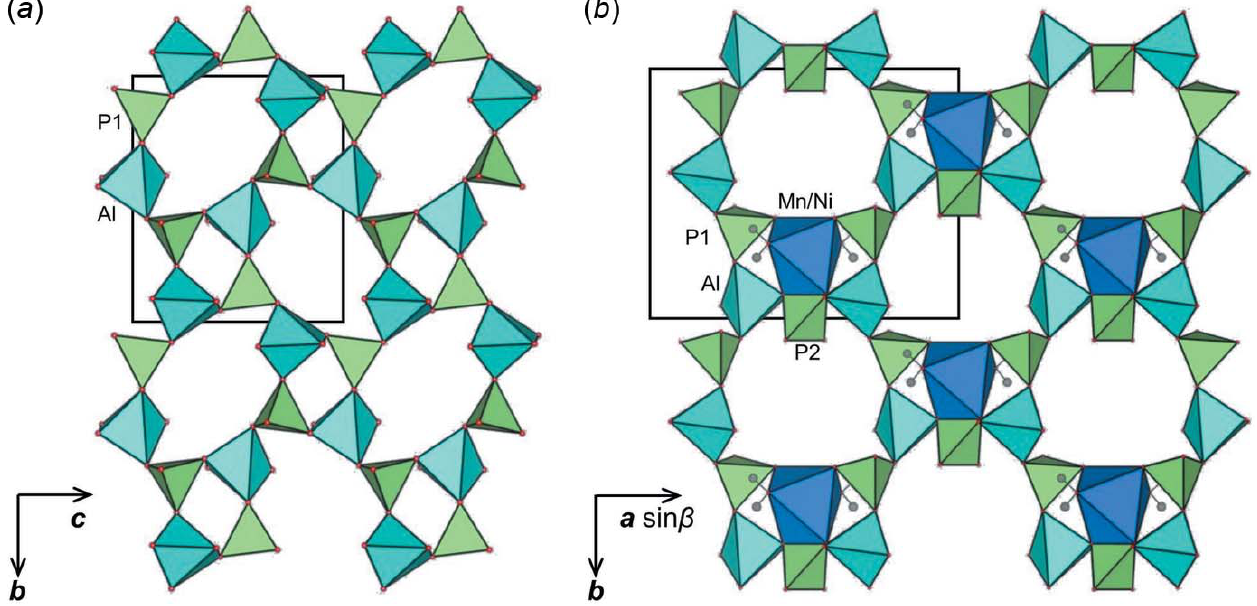
Figure 1 ( a ) Two-dimensional layer formed by four- and eight-membered rings in the bc plane and ( b ) the three-dimensional channels formed by twelve- membered rings in the aluminophosphate framework of Al 2 M (NH 4 )(PO 4 ) 3 (cid:2) 2H 2 O ( M = Mn and Ni) illustrated using VESTA (Momma & Izumi,